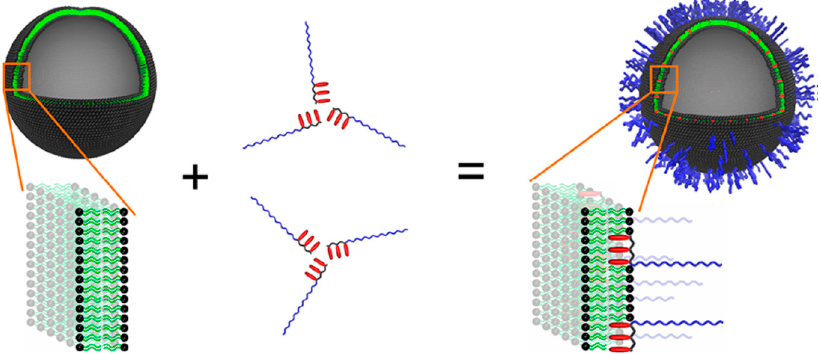
Figure 3. Hybrid stealth liposomes stabilized by cholesteryl-functionalized block copolymers. The cholesteryl moieties (red sticks) insert into the bilayer while the tails (in blue) protrude toward the aqueous phase, protecting the liposomes from coalescence and plasma proteins. Reproduced with permission from [52]. Copyright © 2018 American Chemical